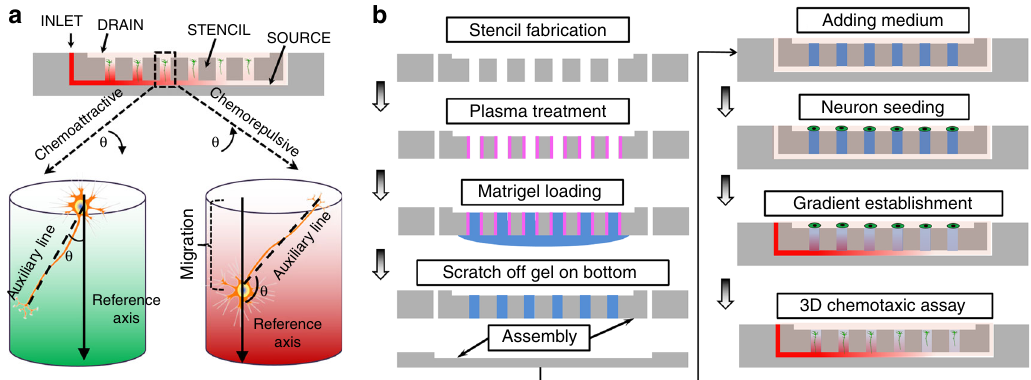
Fig. 1 Design of the high-throughput 3D chemotactic assays. a Schematic showing the use of suspended micro fl uidics for generating molecular gradients with different steepness in an array of hydrogel cylinders. The enlarged inset shows the method to quantify neuronal growth, including neurite guidance and soma migration, for cells cultured in the hydrogel cylinders containing chemoattractive or chemorepulsive cues. b The step-by-step protocol for device assembly and its application to high-throughput 3D